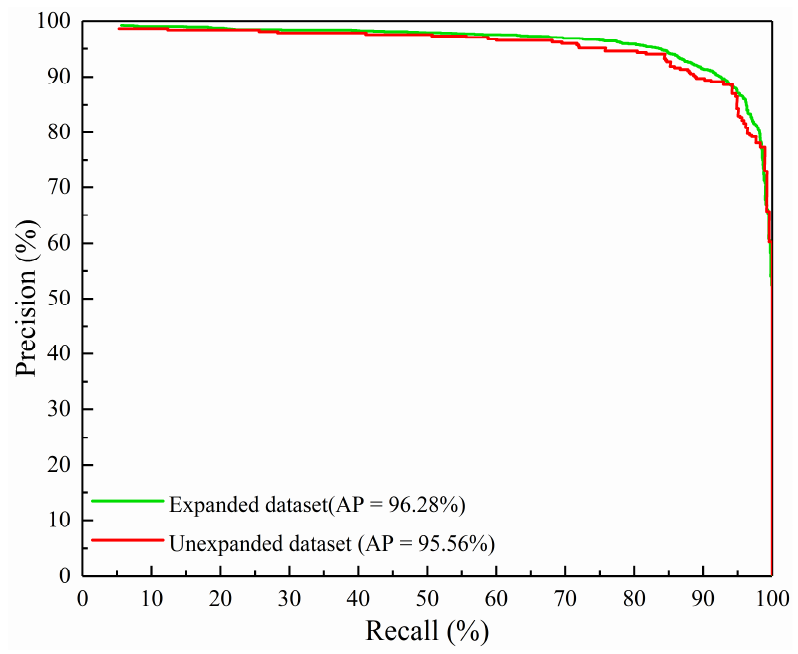
Figure 15. The result of data augmentation. ( a ) Raw images; ( b ) Lighting transformation with δ = 1.5; ( c ) Lighting transformation with δ = 0.5; ( d ) Mirror along the Y axis; ( e ) Mirror along the Y axis.